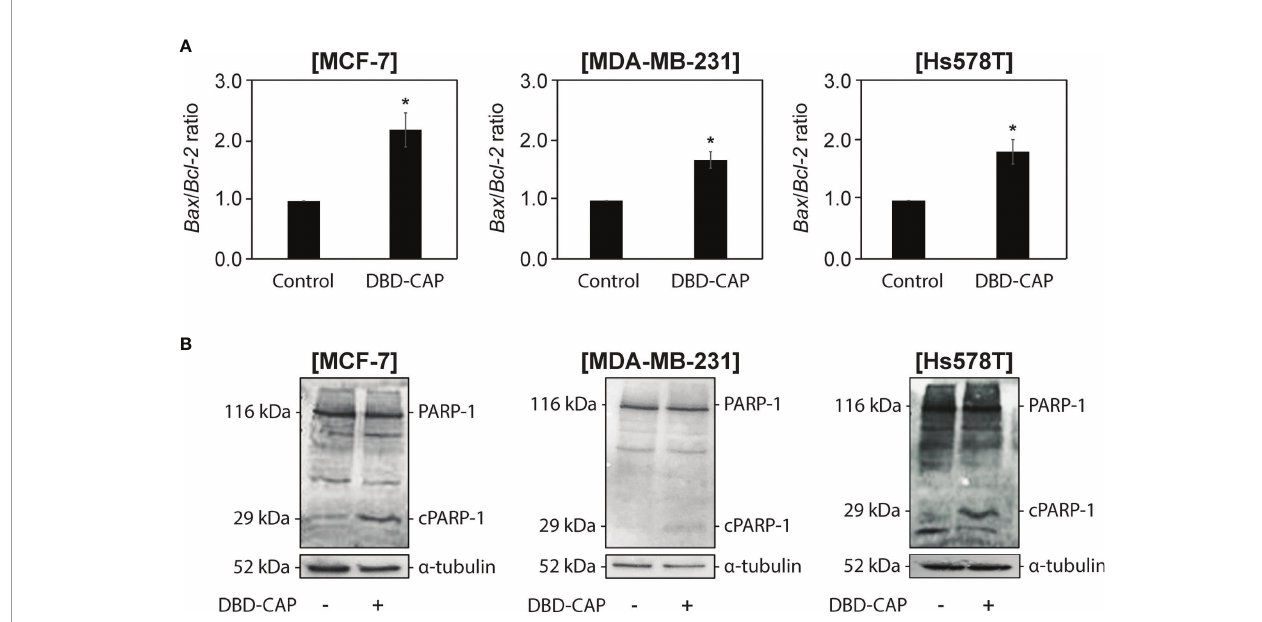
FIGURE 9 | DBD-CAP induces apoptosis in both ER+ and ER- breast cancer cells. (A) Bax/Bcl-2 ratio as estimated from the relative expression of Bax and Bcl-2 to 18S rRNA (housekeeping gene) mRNA levels by quantitative qPCR analysis in MCF-7/ER+, MDA-MB-231/ER- and Hs578T/ER- cells treated with mild (0.5 kHz/ 27.6 kV) direct DBD-CAP for 4 min. The values represent the mean ± SD of 3 (at least) independent experiments. Asterisks illustrate signi fi cant differences between control (untreated) and DBD-CAP-treated cells (* p < 0.05). (B) Immunoblot analyses of PARP-1/cPARP-1 and a -tubulin (loading control) in MCF-7/ER+, MDA-MB- 231/ER- and Hs578T/ER- untreated (left lane) or treated with mild (0.5 kHz/27.6 kV) direct DBD-CAP for 4 min (right lane). Representative blots are